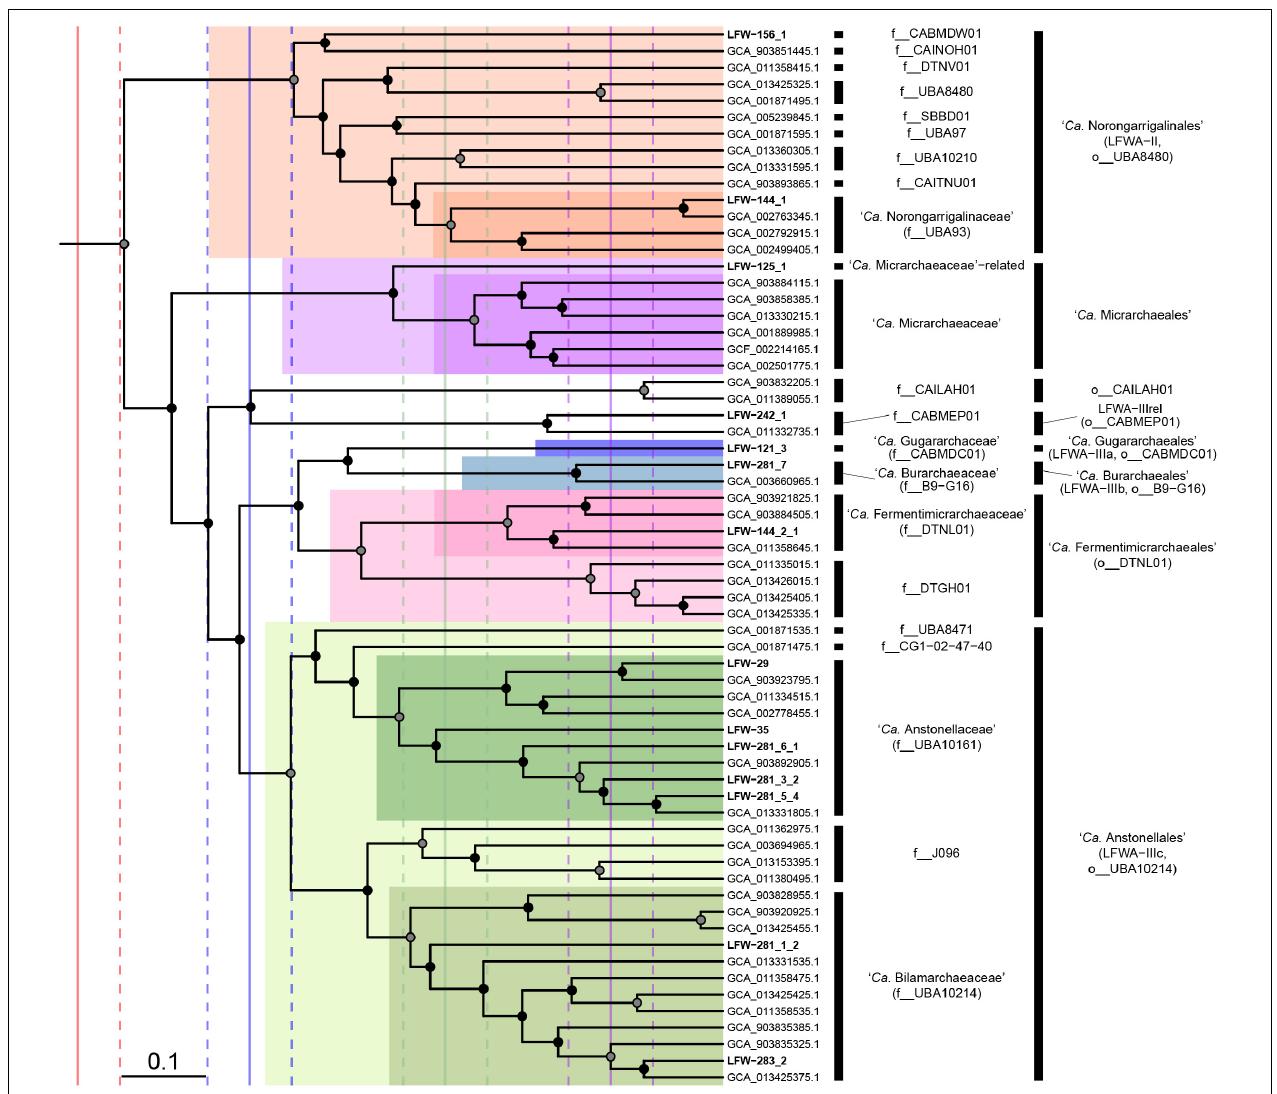
FIGURE 3 | Phylogenomic placement of the ‘ Candidatus Micrarchaeota’ orders and families. Subtree extracted from the RED-scaled concatenated DPANN phylogenomic tree based on GTDB r202 highlighting families and orders. Filled circles indicate UFBoot support ≥ 90% in the dpann_r202-concat tree. Scale bar indicates RED. Solid vertical lines indicate median RED values for class (red), order (blue), family (green), and genus (purple). Dashed lines indicate ± 0.05 units around RED median values.